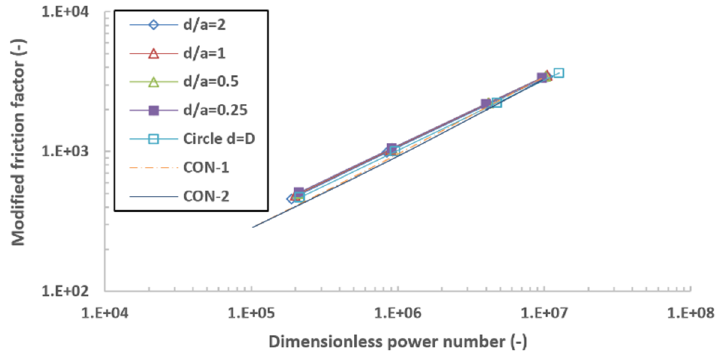
Figure 13. The modified friction factor, associated with the connecting filament diameter, as a function of the dimensionless power number. A comparison was made with the modified friction factor of Haaksman et al. [23].